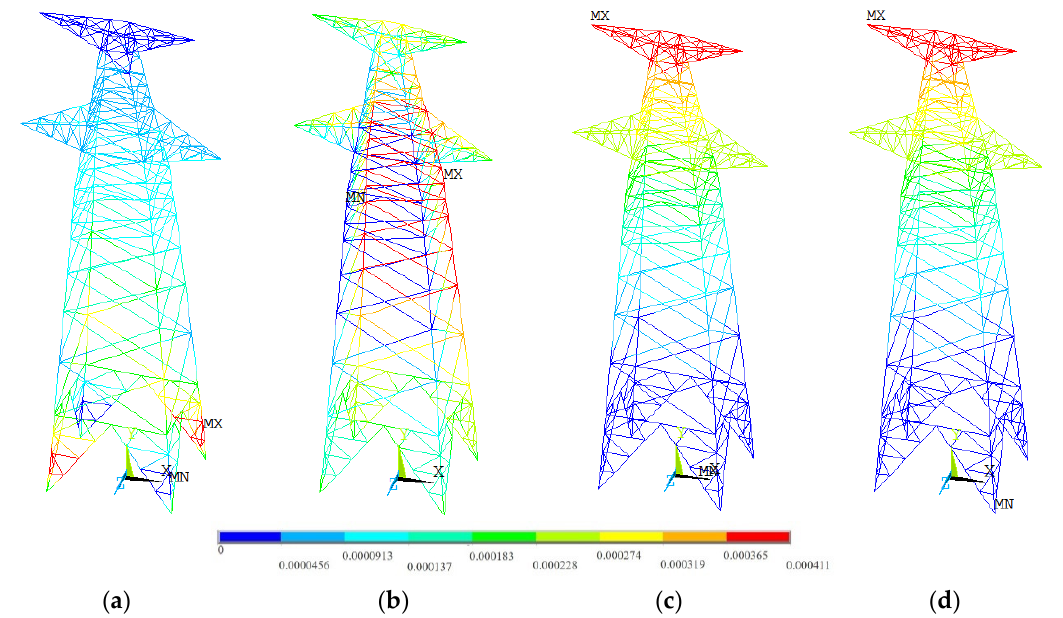
Figure 4. Displacement of the transmission tower in the first order vibration mode; ( a – c ) are the results in the X, Y and Z directions, respectively, and ( d ) is the sum vector result.